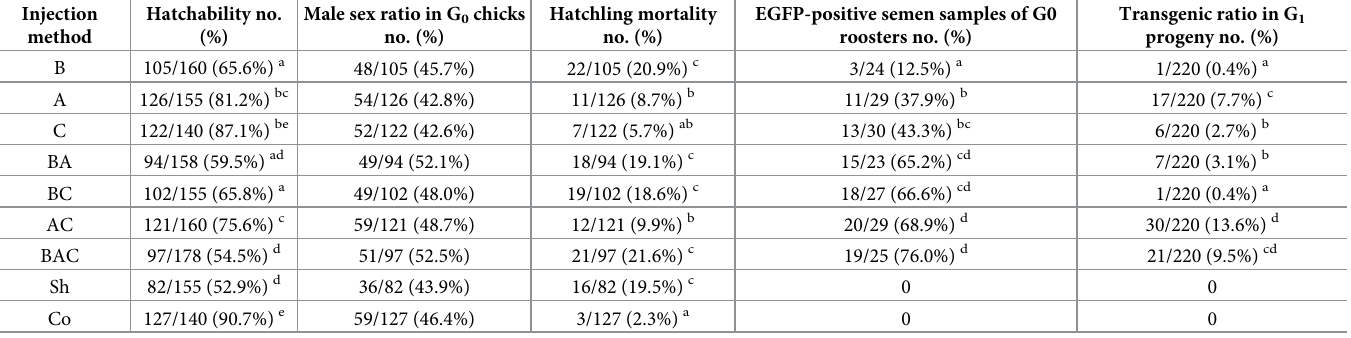
Table 1. Hatchability, sex ratio, hatchling mortality, transgenic frequency, and germline transmission efficiency in chimeric chickens produced by different injec- tion routes of viral vector administration. Injection method